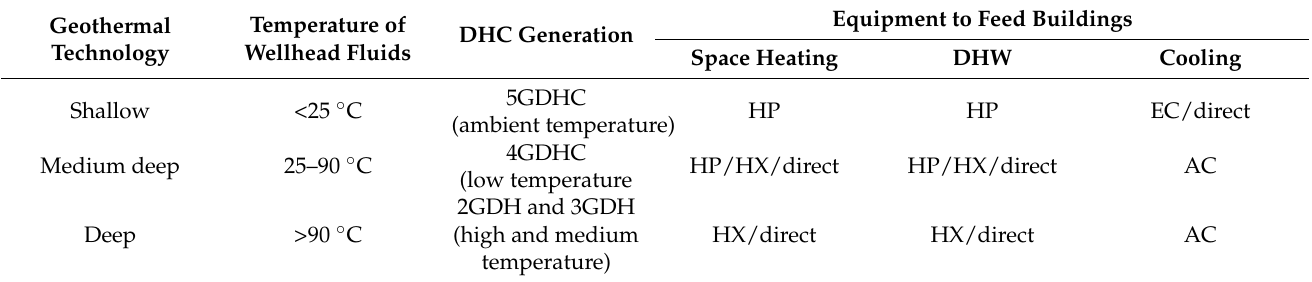
Table 5. Classification of geothermal